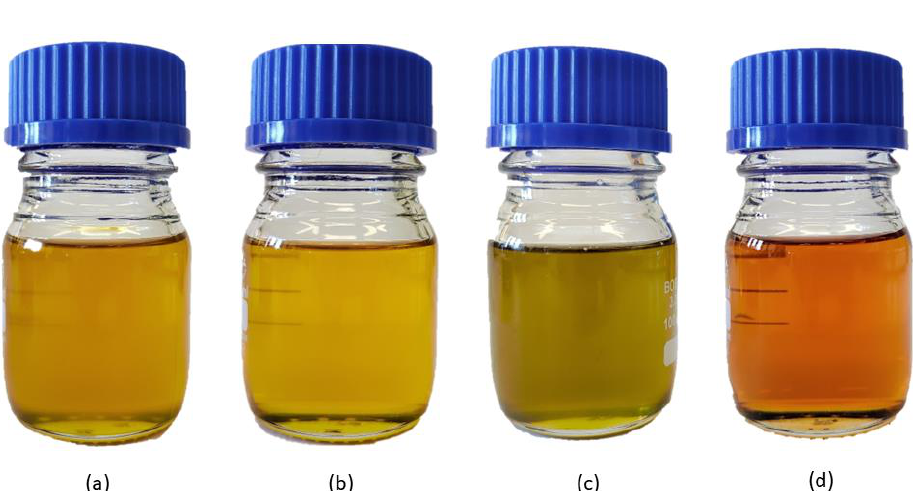
Figure 3. Oils used: ( a ) crude rapeseed oil; ( b ) crude oilseed radish oil; ( c ) crude hemp seed oil; ( d ) used cooking oil.